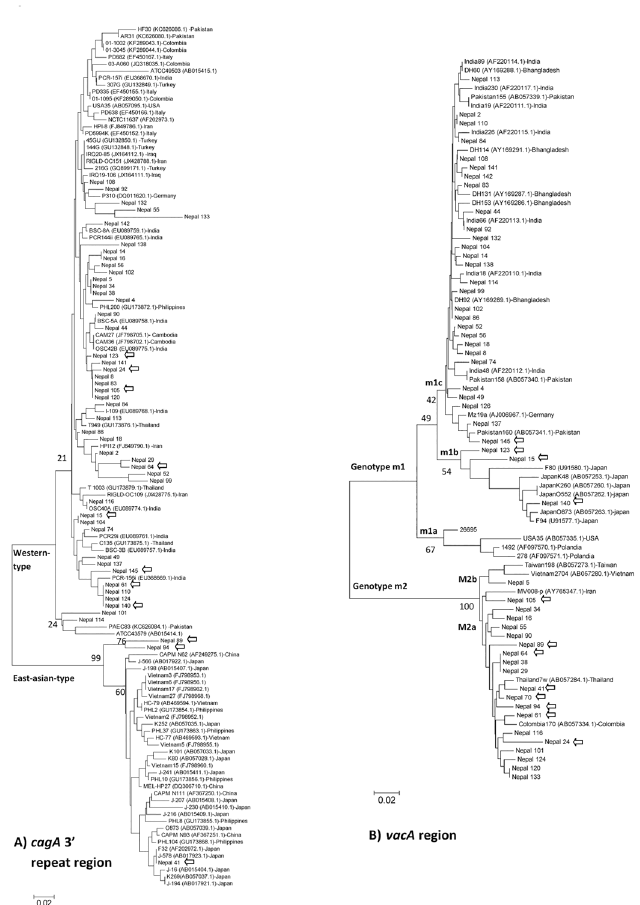
Fig 2. Phylogenetic analysis of the cagA 3´ repeat region (A), vacA m region (B), and reference sequences of Helicobacter pylori . Genetic distances were estimated by the six-parameter method and phylogenetic trees were constructed by the neighbor-joining method. Strains with GenBank accession numbers are reference strains. Bootstrap values are shown along each main branch. The lengths of the horizontal bars indicate the number of nucleotide substitutions per